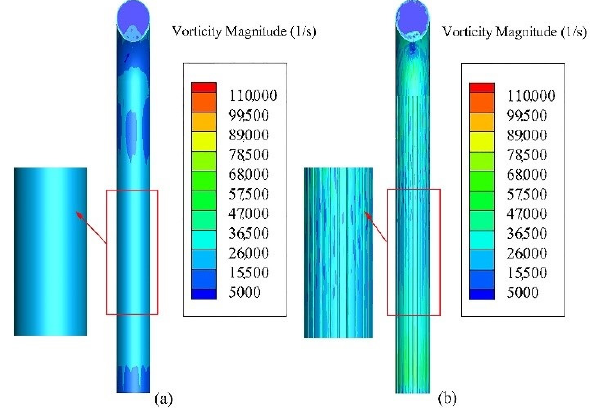
Figure 16. Vorticity amplitude nephogram ( a ) prototype and ( b ) bionic tailpipe.